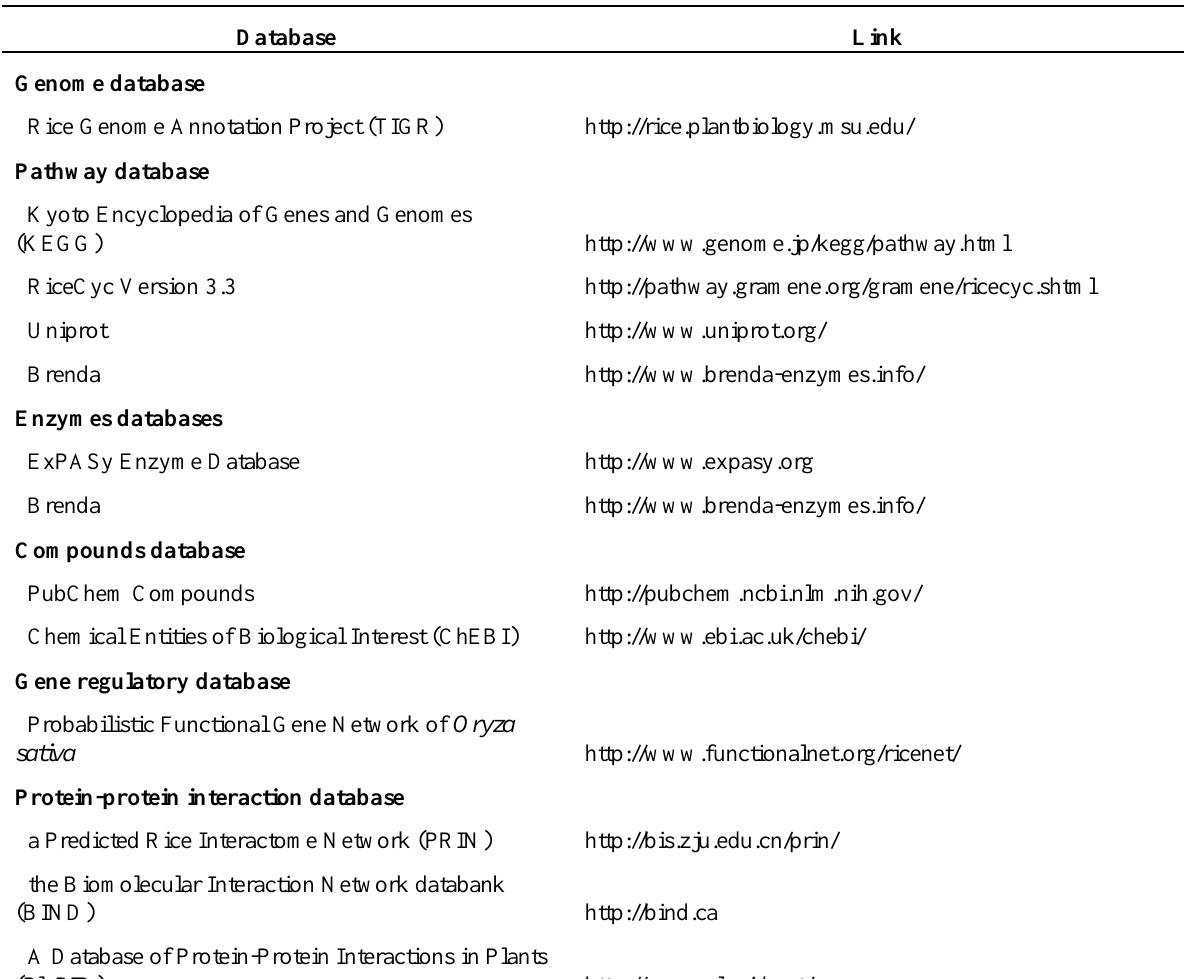
Table 1: Online resources for the reconstruction of rice multi-level